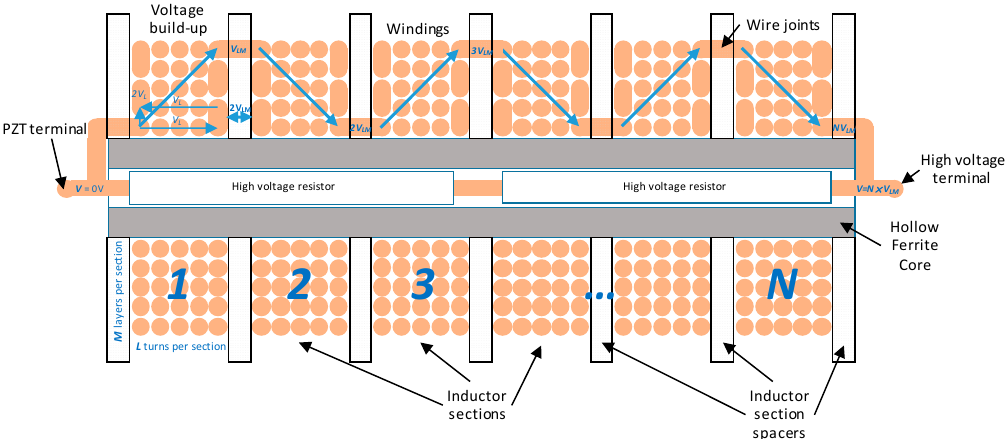
Figure 19. Schematic diagram of the attenuator electrical connections (winding diameter and the components are not drawn to scale).